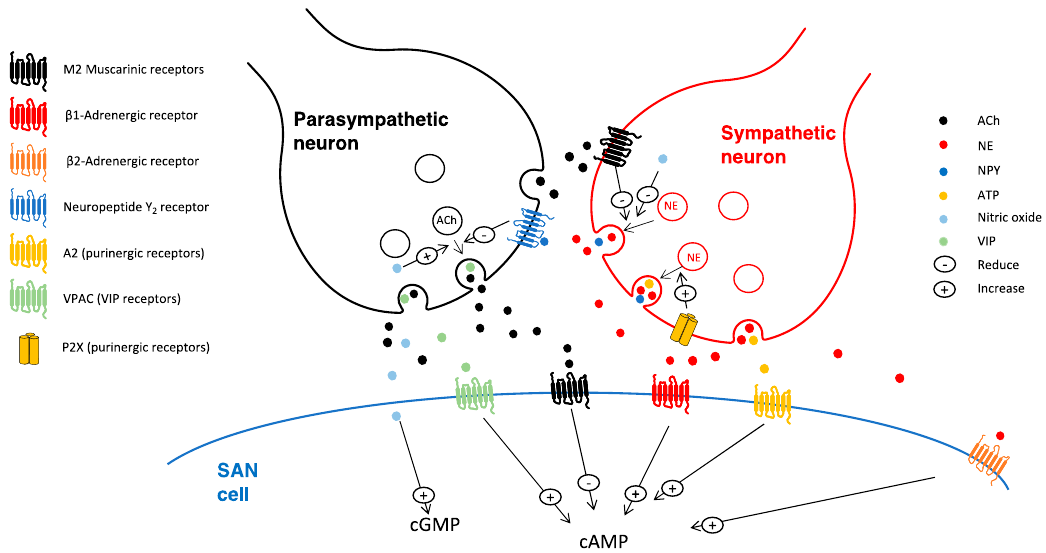
Figure 5. Diagram illustrating the crosstalk by the sympathetic and parasympathetic varicosities at the level of a sinoatrial node myocyte. The parasympathetic neuron can release acetylcholine, nitric oxide and vasoactive intestinal peptide, whilst the sympathetic neuron norepinephrine, ATP and neuropeptide Y. This figure was created using images from Servier Medical Art Commons Attribution 3.0 Unported License (http://smart.servier.com). Servier Medical Art by Servier is licensed